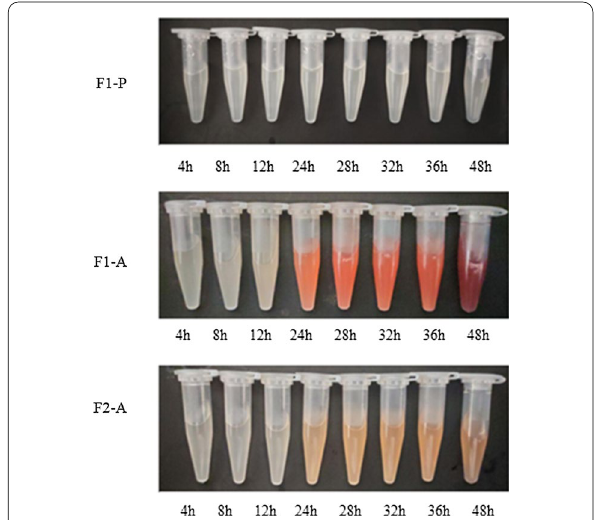
Fig. 3 Color of fermentation broth F1-P, F1-A and F2-A